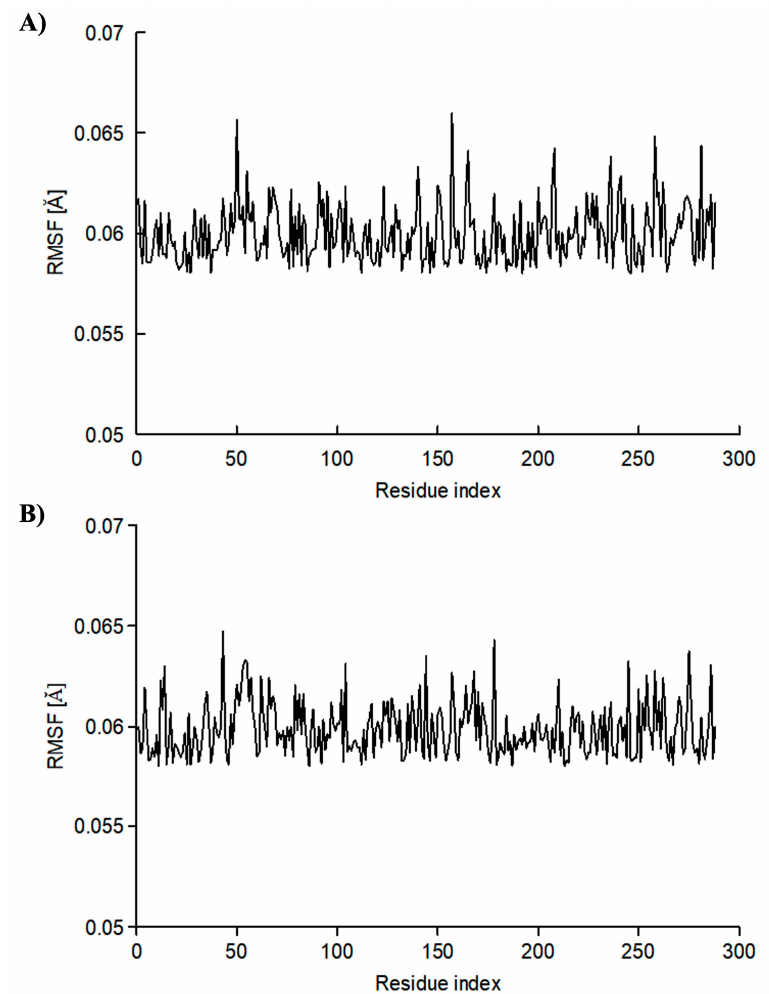
Figure 5. Residue-wise root-mean-square fluctuation (RMSF) value for the HNMT–ligand complex obtained during MD simulations; HNMT–vilazodone complex ( A ) and HNMT–dihydroergotamine complex ( B ).